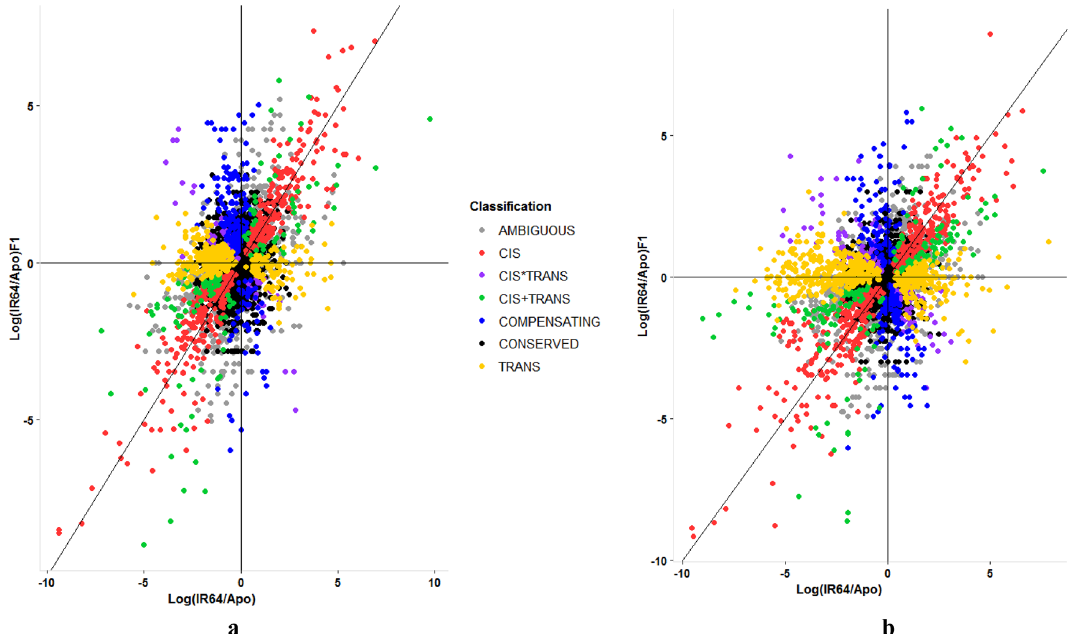
Figure 1. The “scattering” effect of drought stress on cis and/or trans regulatory architecture between two indica genotypes: IR64 and Apo under ( a ) non- and ( b ) water-stress conditions. Visual inspection of the two graphs shows more dispersed points of B compared to A. X-axis indicates expression ratios (in log 2 ) between the parental genotypes, Log 2 (IR64/Apo); Y-axis, between the two parent-specific alleles in the hybrid, Log 2 (IR64/ Apo)F1. Figures generated using ggplot2 (https:// ggplo t2. tidyv erse. org) 23 in R (v 4.0.2 Comprehensive R Archive Network (CRAN); https:// www.R- proje ct. org) 24